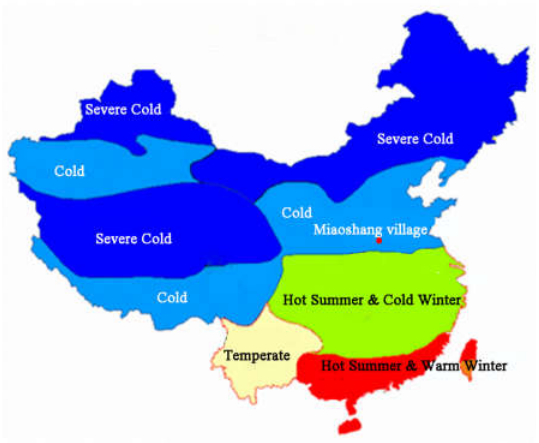
Figure 2. The map of the climate regions of China illustrates the site.